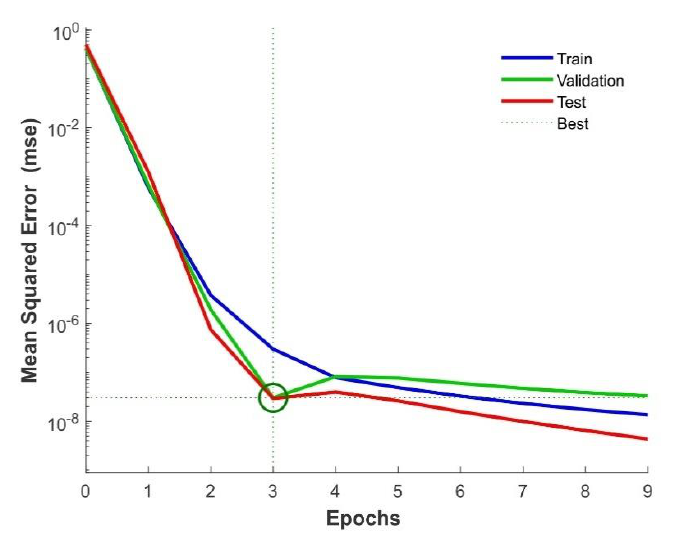
Figure 8. Best validation performance using the ANN for processed data reliability.